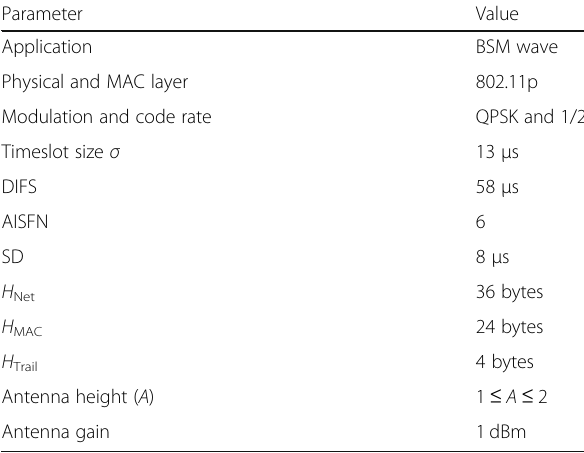
Table 2 The parameters used in NS3 simulation and devices